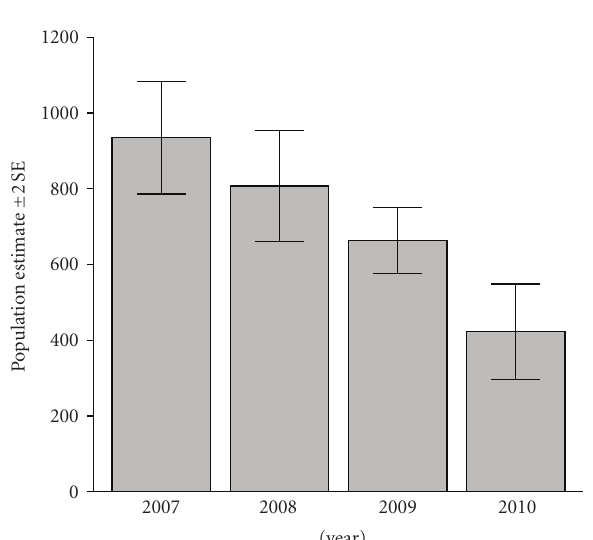
Figure 3: Population estimate of free-ranging white-tailed deer within the Bovine Tuberculosis Core Area, winters 2007–2010, northwest